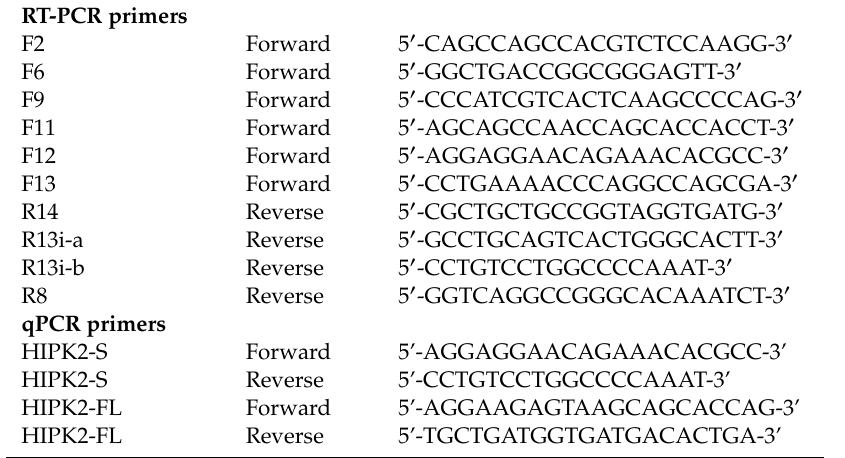
Table 1. HIPK2 isoform specific primers.